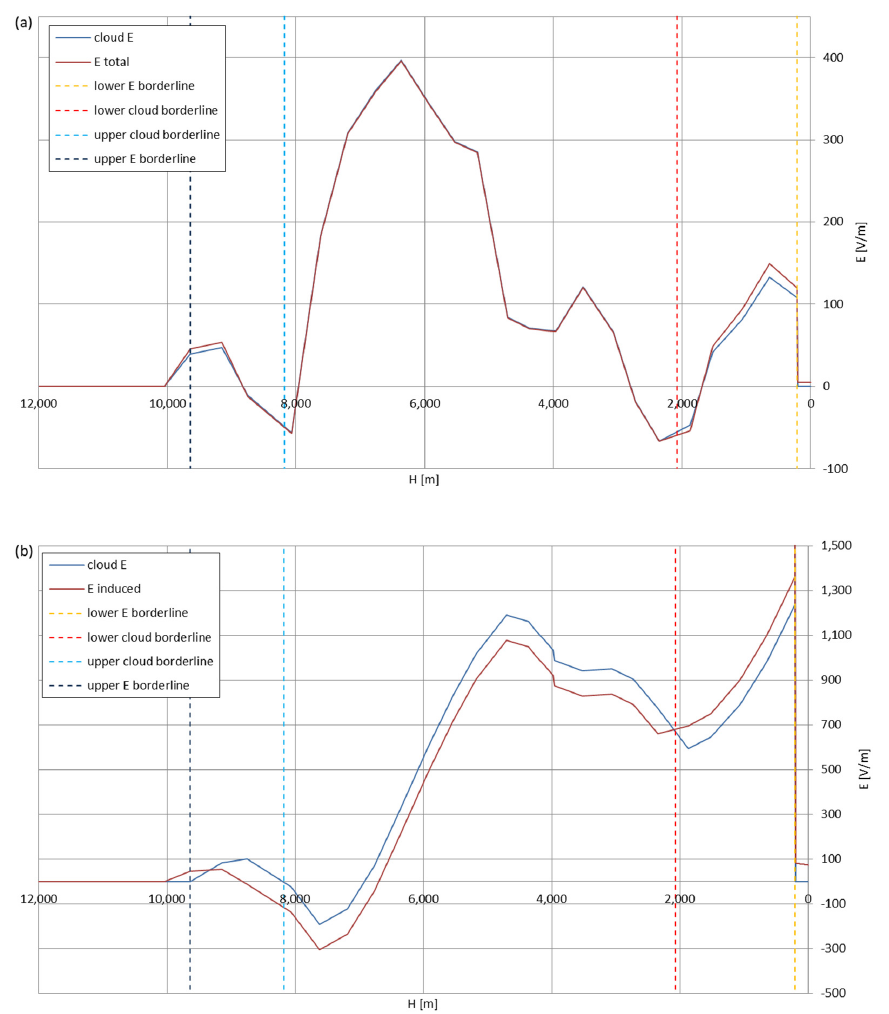
Figure 17. Maximum electric field strengths around the wire antenna re-entering through Nimbostratus cloud of mixed charge structure, Sankt Petersburg data: ( a ) ‘static’ case and ( b ) ‘dynamic’ case.